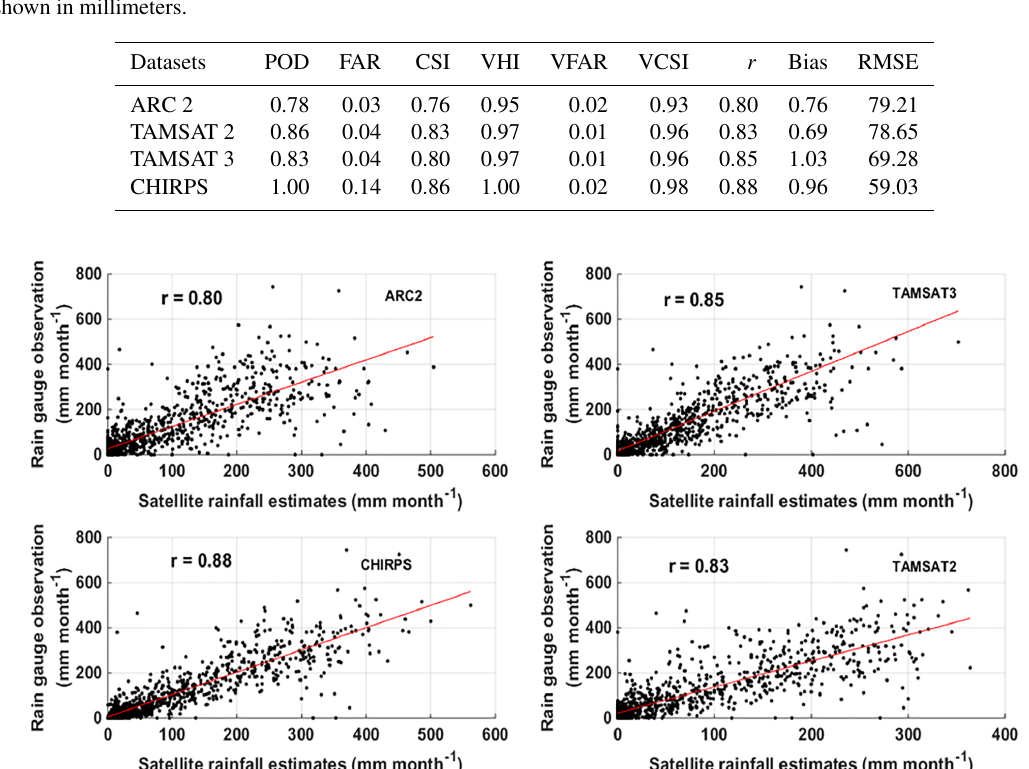
Figure 8. Scatter plot between rain gauge observations and satellite rainfall estimates at a monthly temporal scale over the Upper Blue Nile basin for the period of